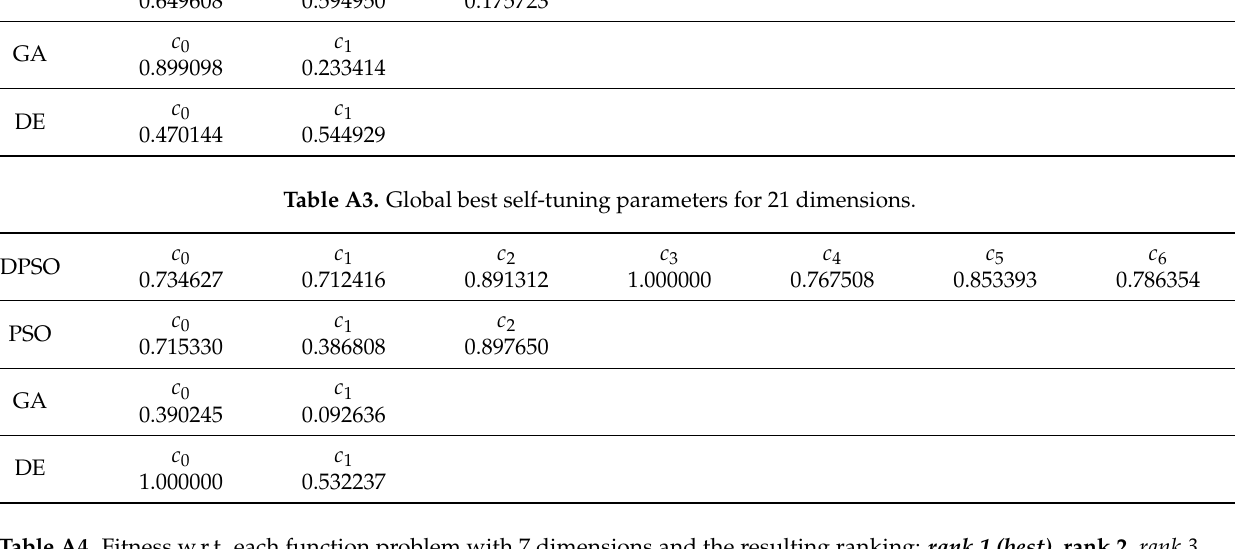
Table A4. Fitness w.r.t. each function problem with 7 dimensions and the resulting ranking: rank 1 (best) , rank 2 , rank 3 , and rank